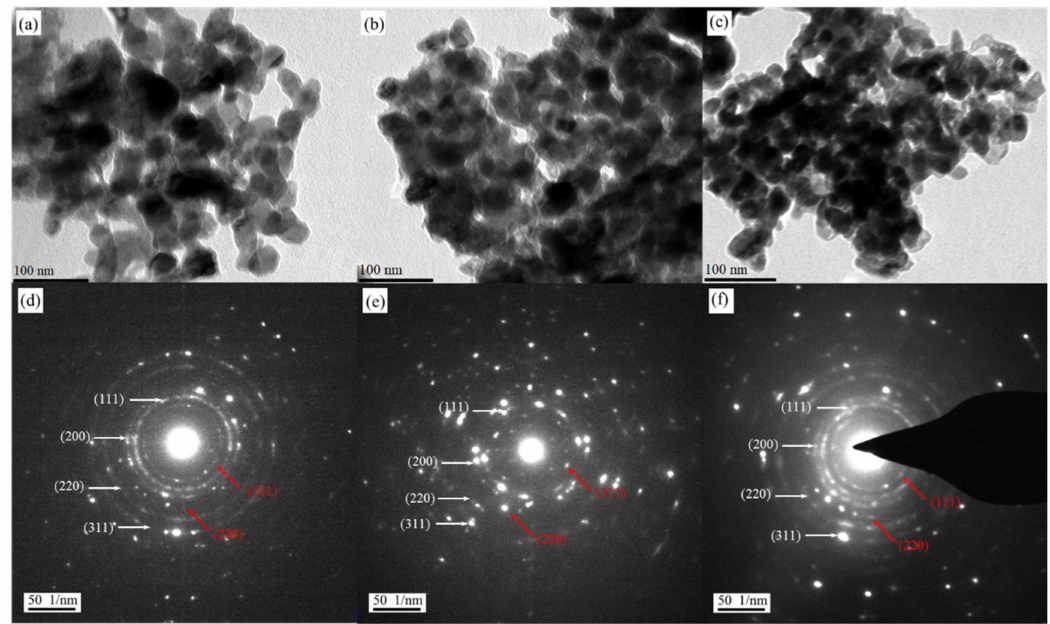
Figure 1. TEM images and SAED patterns of nanoporous catalysts prepared by dealloying MnCu ( a , d ), MnCuNi ( b , e ), and MnCuAl ( c , f ). The XRD patterns of NPC1, NPC2, and NPC3 are exhibited in Figure 2a. The diffraction peaks at about 43.6 ◦ , 51.1 ◦ , and 74.8 ◦ were assigned to Cu, and some diffraction peaks originating from Cu 2 O were confirmed. The NPC2 sample with a minor addition of Ni did not cause the emergence of a new phase; this is due to the complete solubility in the Cu-Ni system. As for the NPC3 sample, the addition of Al element was etched away during the dealloying process. The nitrogen adsorption–desorption isotherms and the corresponding pore size distribution of NPC1, NPC2, and NPC3 are exhibited in Figure 2b. It can be seen clearly that the sorption isotherms exhibited hysteresis loops, which were caused by the porous characteristics. The BET surface area for NPC1, NPC2, and NPC3 were 28.832, 31.739, and 36.455 m 2 g − 1 , respectively. The NPC3 catalyst got the relatively high surface area.